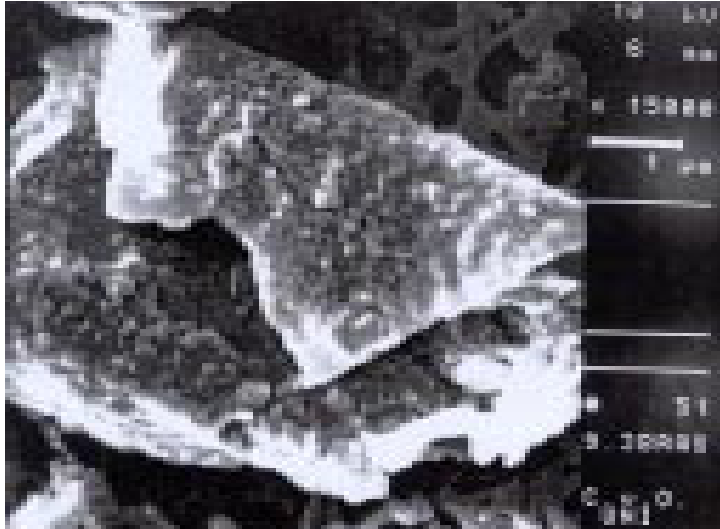
Figura 6. Fotografia obtida por microscopia eletrônica de varredura, mostrando pseudomorfoses de montmorilonita, para caulinita, no horizonte 2Btn do perfil 9